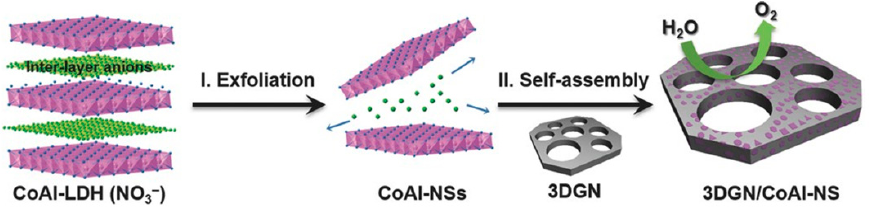
Figure 7 . 3D graphene assisted formation of the porous electrocatalyst 3DGN/CoAl ‐ NS. Reproduced from [33], with permission from John Wiley and Sons, copyright 2016.